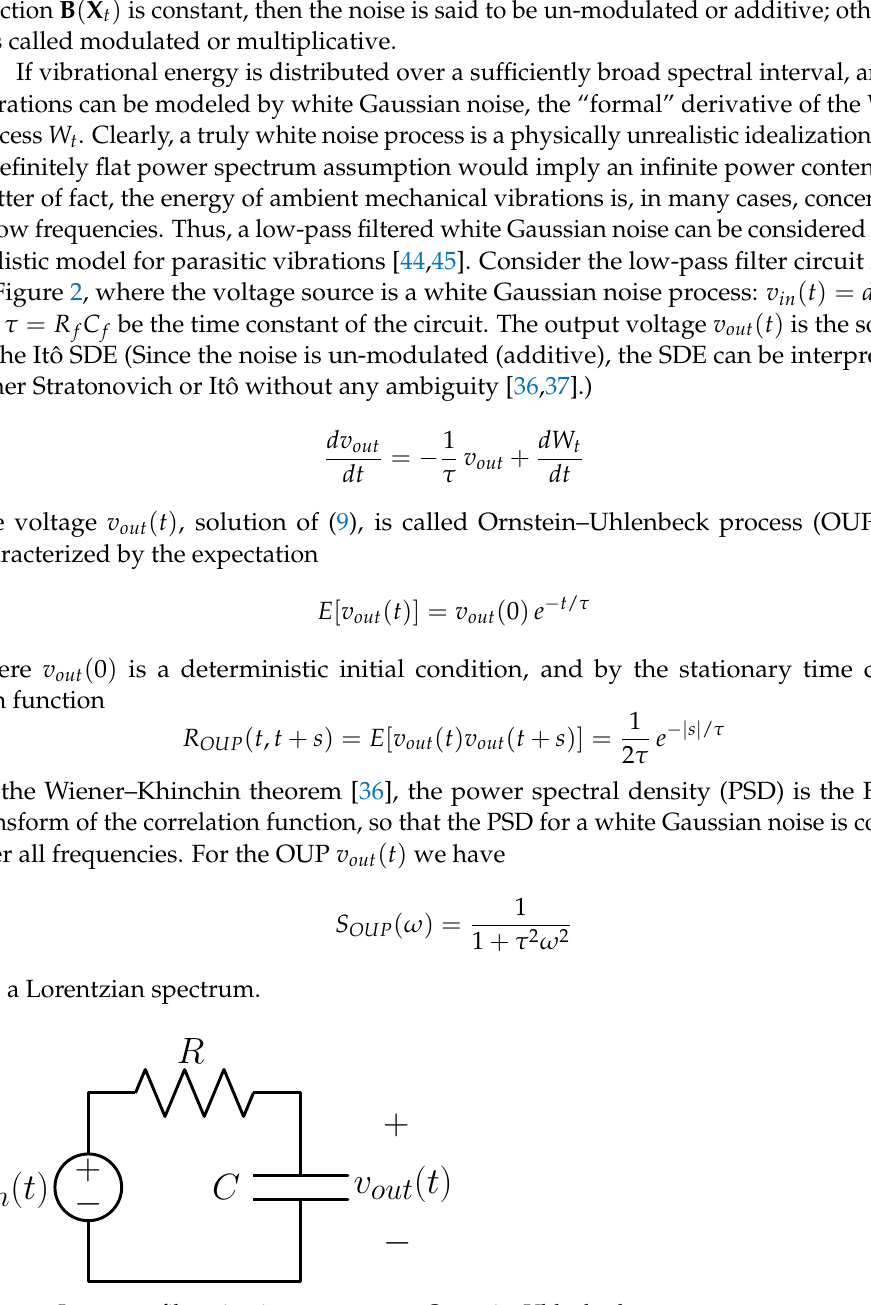
Figure 2. Low-pass filter circuit to generate an Ornstein–Uhlenbeck